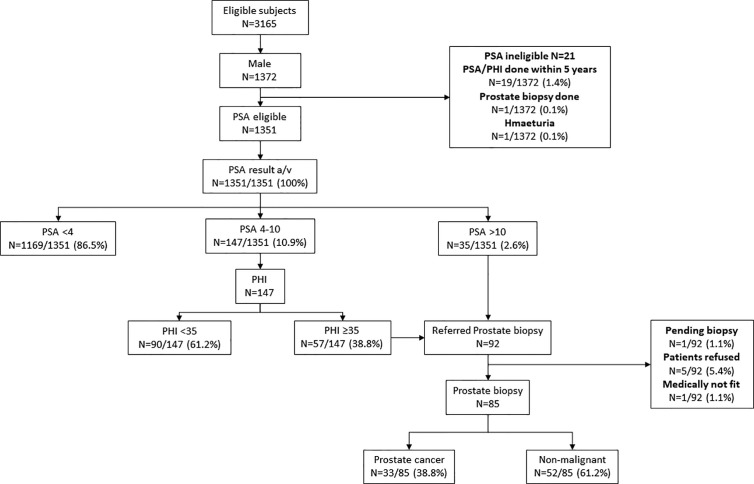
Study flow. CRC, colorectal cancer; PC, prostate cancer; BC, breast cancer; FIT, fecal immunochemical test; PSA, prostate surface antigen; PHI, prostate health index; and MMG, mammogram.